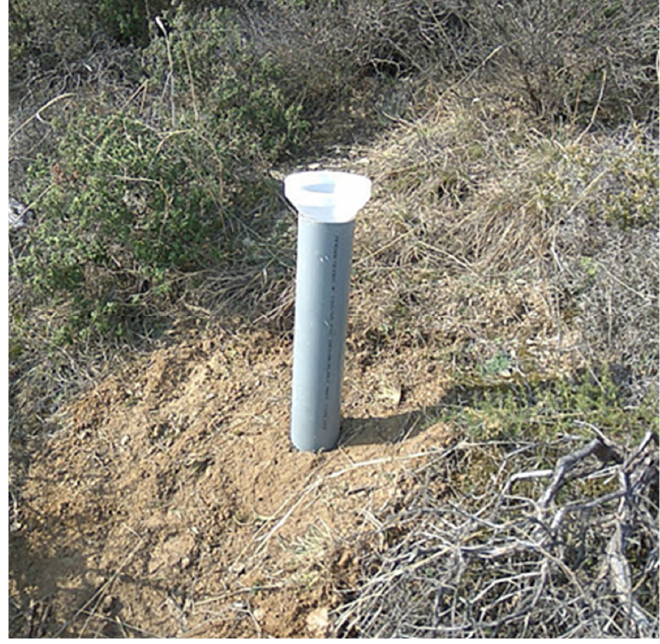
Figure 11. View of the installed cumulative rain gauge in the study area.